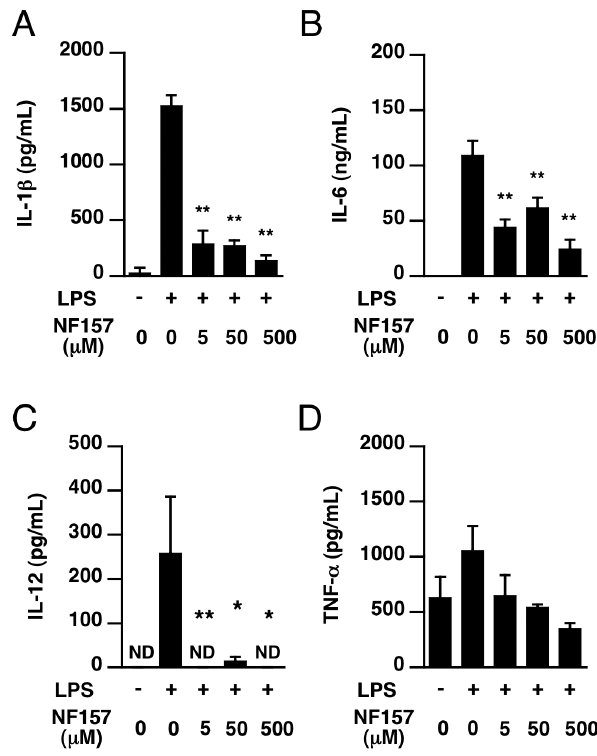
Figure 8. P2Y11 antagonist NF157 suppressed the increase in serum levels of cytokines in LPS-treated mice. ( A – D ) Male C57BL/ 6 mice at 6 weeks of age were given LPS (400 m g/head i.p.). NF157 (100 m L) doses of 5, 50 and 500 m M were administered intraperitoneally at 2 h before LPS was injected. Blood samples were collected at 6 h after LPS injection. Serum levels of IL-1ß, IL-6, IL-12 and TNF-alpha were determined as described in Materials and Methods . Each value represents the mean 6 SE (n=4). Significant differences between a test group and control group (LPS alone) are indicated by *(p , 0.05) and **(p , 0.01),